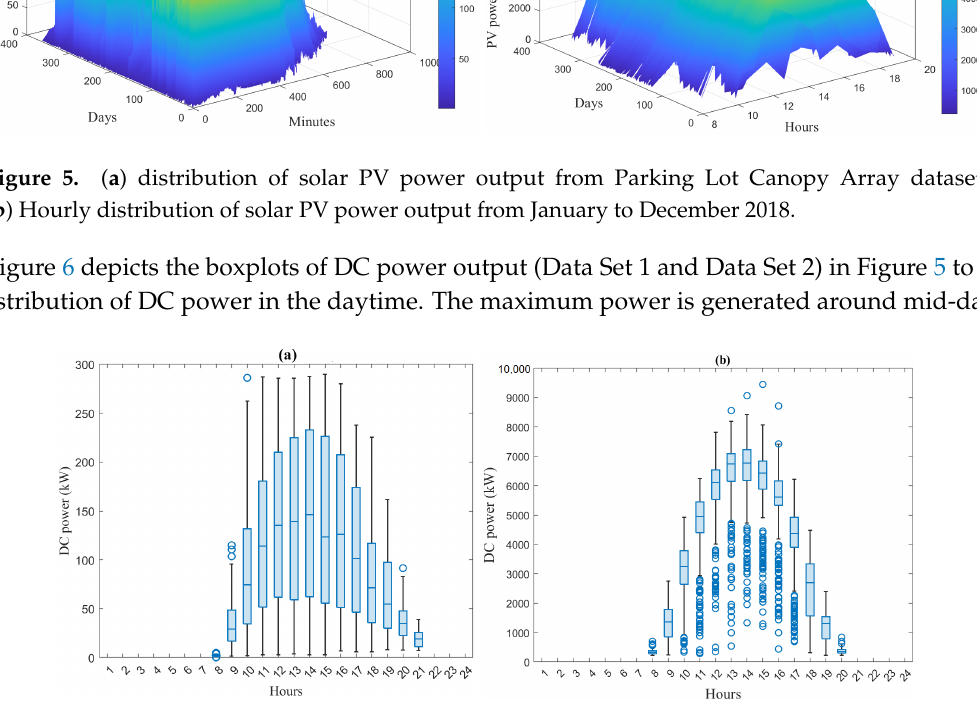
Figure 6. Boxplots of PV power output during daytime hours: ( a ) Data Set 1 and ( b ) Data Set